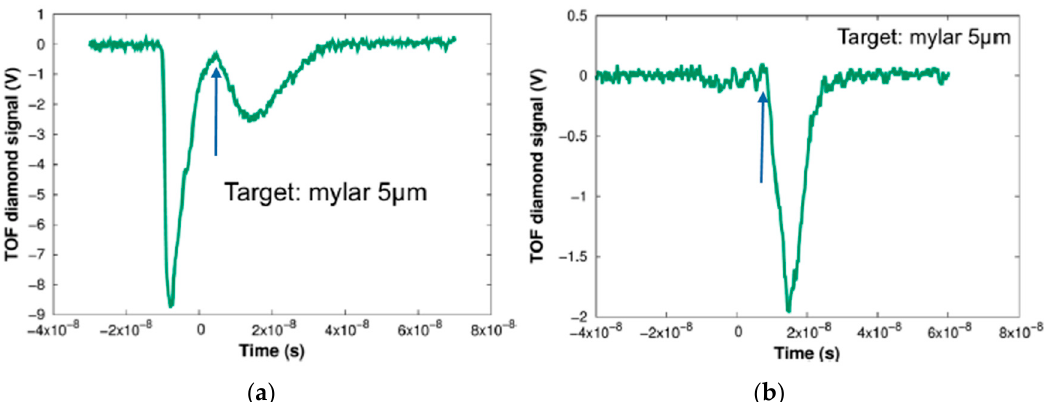
Figure 6. ( a ) Raw signal of the diamond Time of Flight (TOF) detector showing the ion signal from the irradiation of a 5 μ m thick Mylar target corresponding to ions between 1.9 MeV and 0.8 MeV. T = 0 is arbitrary in this plot. The strong emission at T = − 10 ns is the signal due to fast electrons. ( b ) Same measurement as ( a ), but with magnetic shielding in front of the diamond detector. The blue arrow indicate the onset of the ion signal corresponding to the cut-off energy.